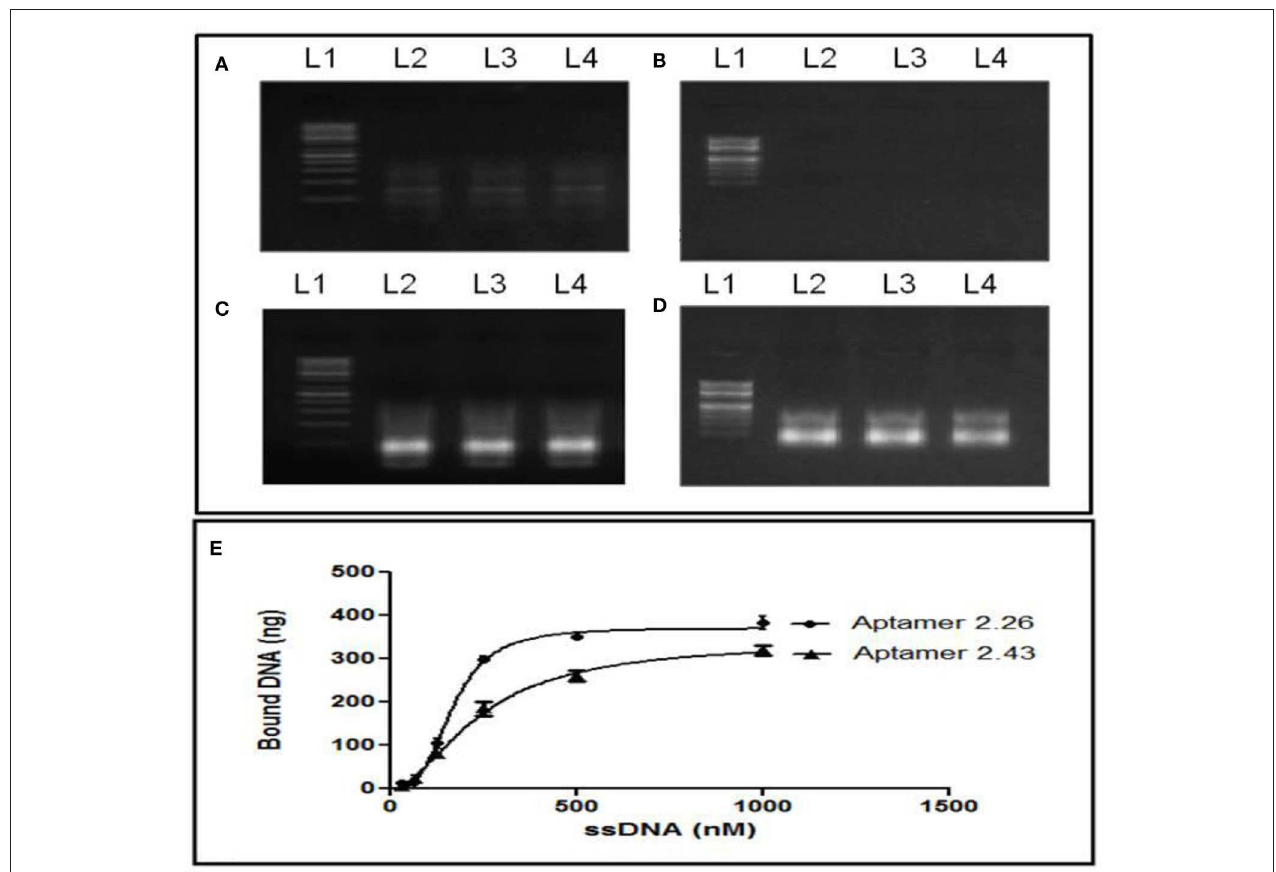
FIGURE 4 | Serum stability profiling: (A) PCR amplified DNA and (B) its single-stranded form before amplification, after treatment with 50%v/v normal human female serum. Effect of different salt concentrations on aptamer-CA125 binding: (C) negative controls and (D) treated aptamer (lane 1: ladder, lane 2: 0.2M NaHCO 3 with 0.5M NaCl, lane 3: 100mM NaCl and 5mM MgCl 2, lane 4: milli-Q water as positive control; (E) Binding—saturation curve for determination of K D . The original gel images have been provided in Figures S4, S5